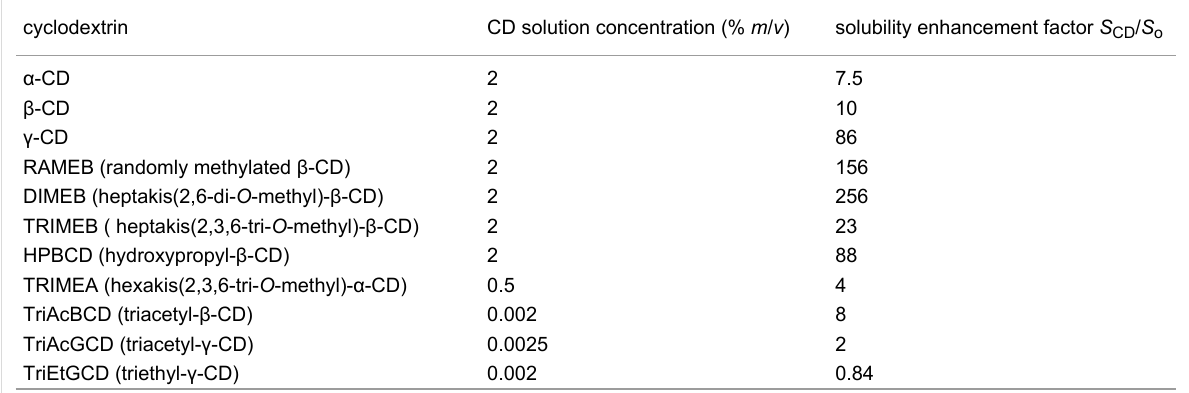
Table 2: Solubility enhancement factors a for 2ME with various cyclodextrins at 25 °C. cyclodextrin